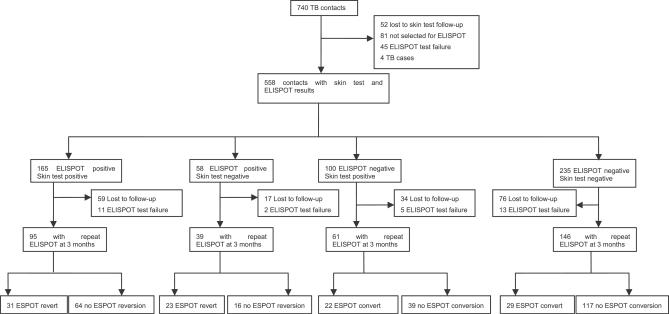
Study Profile: Recruitment and 3-Mo ELISPOT Conversion and Reversion